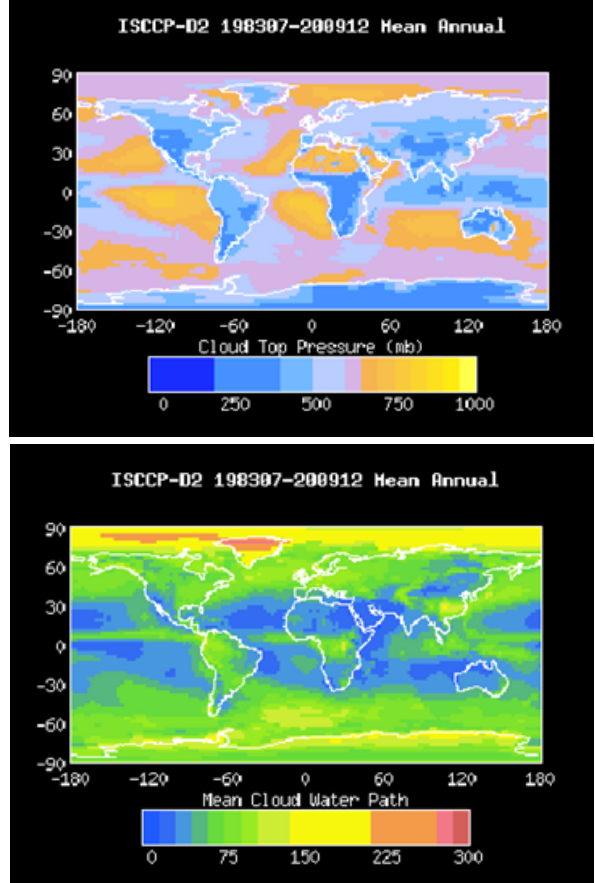
Fig. 7. Global mean annual ISCCP cloud top pressure (left) and Figure 7. Global mean annual ISCCP cloud top pressure (left) and mean cloud water path mean cloud water path amount (right) (http://isccp.giss.nasa.gov/ amount (right) (www.isccp.giss.nasa.gov).